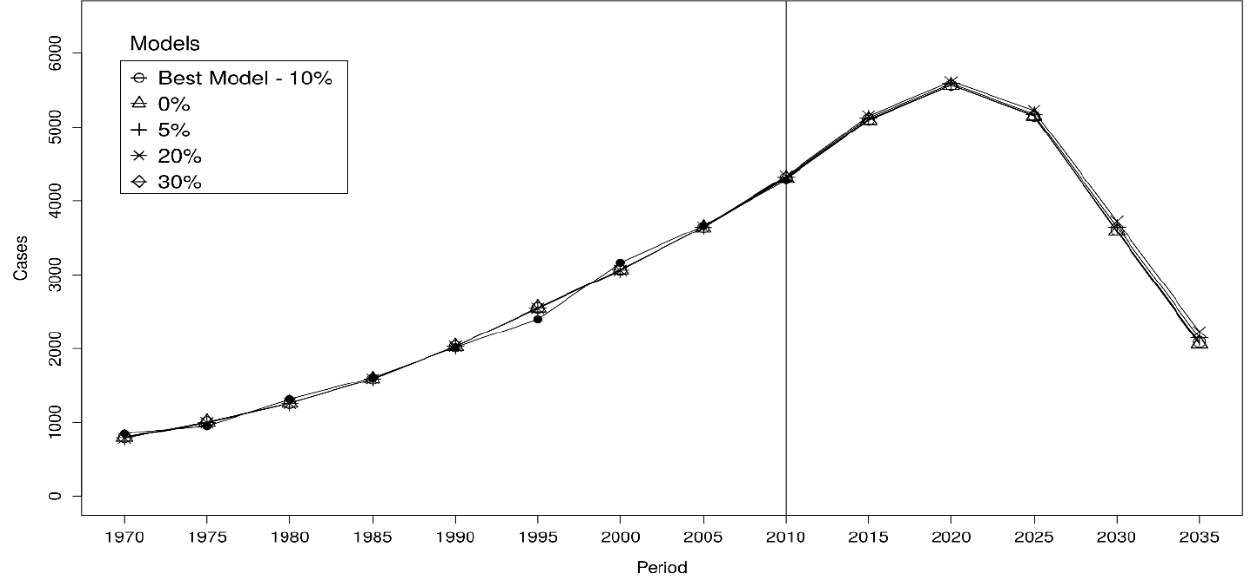
Figure 5. Predictions based on different assumption on asbestos exposure after 1992. Black dots indicate observed cases.